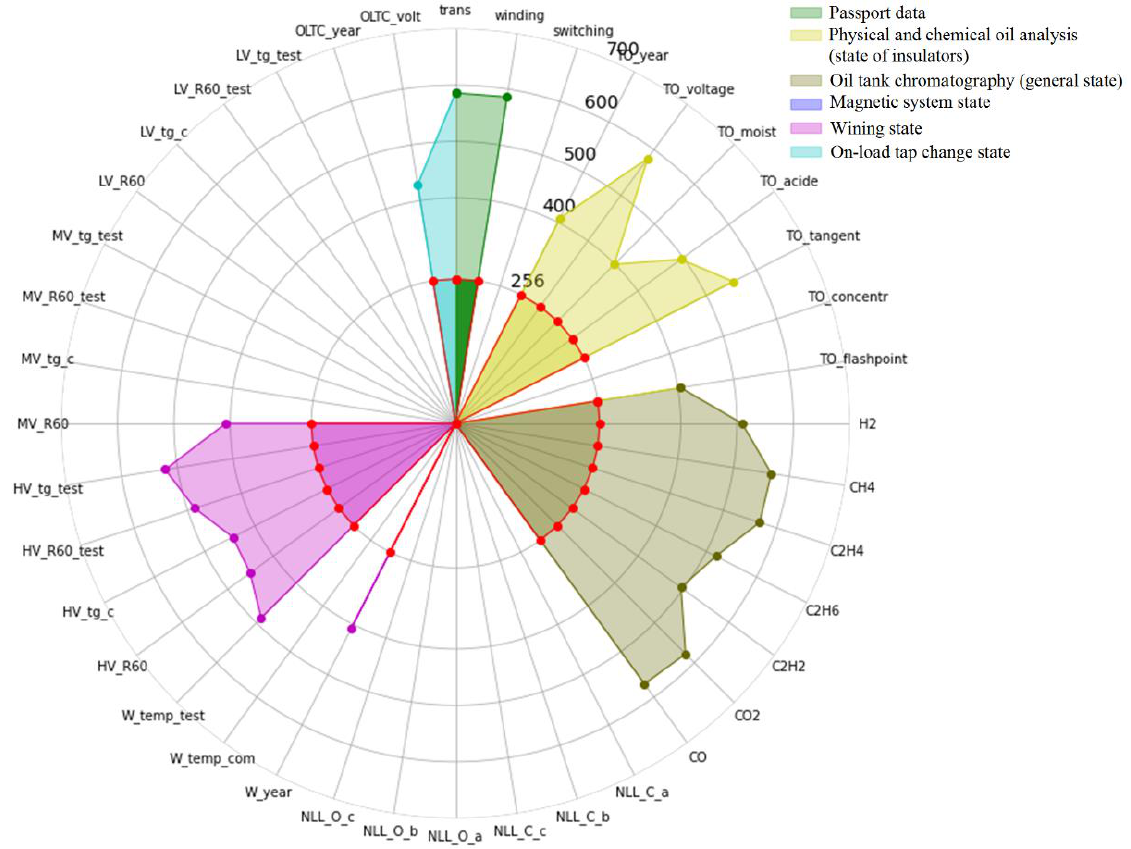
Figure 5. Data area diagram for power transformer dataset after removing the outliers.